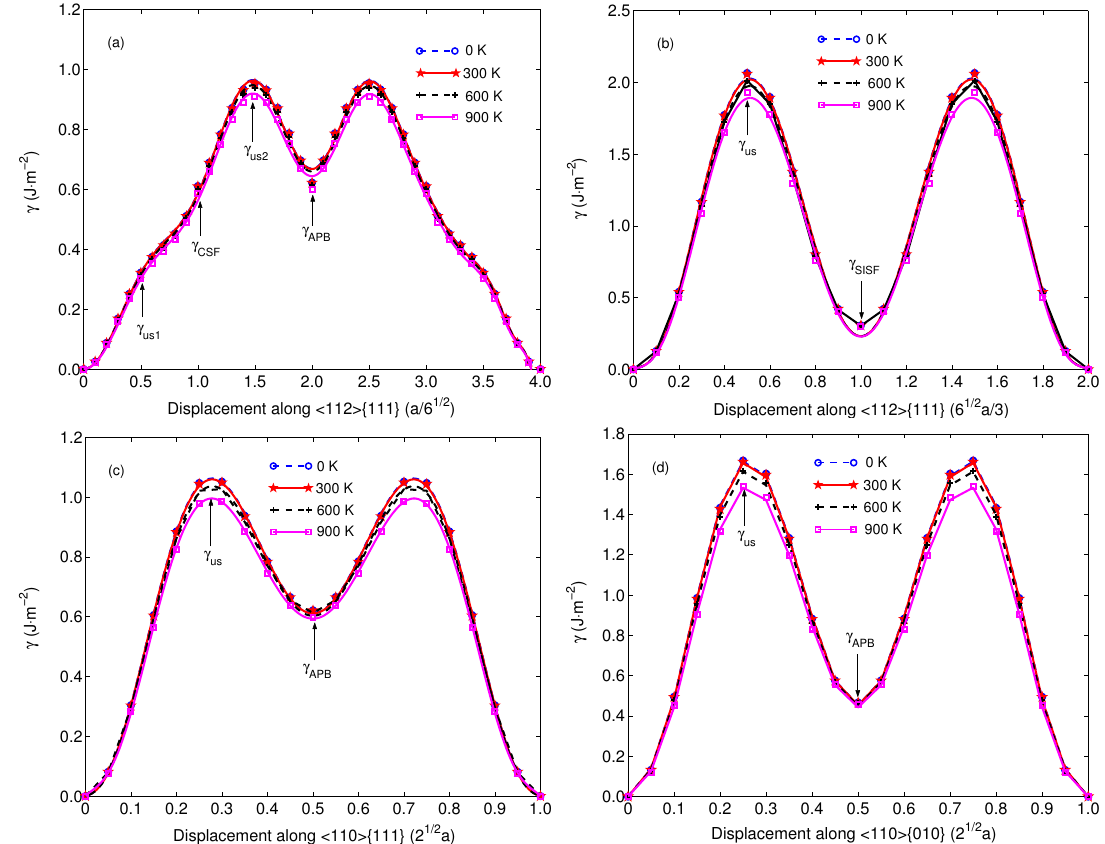
Figure 5. The calculated generalized stacking fault energy curves for Ni 3 Ge ( a ) sliding along (cid:104) 112 (cid:105){ 111 } ( a /6 1/2 ), ( b ) sliding along (cid:104) 112 (cid:105){ 111 } (6 1/2 a /3), ( c ) sliding along (cid:104) 110 (cid:105){ 111 } (2 1/2 a ) and ( d ) sliding along (cid:104) 110 (cid:105){ 010 } (2 1/2 a ). The discrete points represent the results from first-principles calculations and the curves denote the results from polynomial